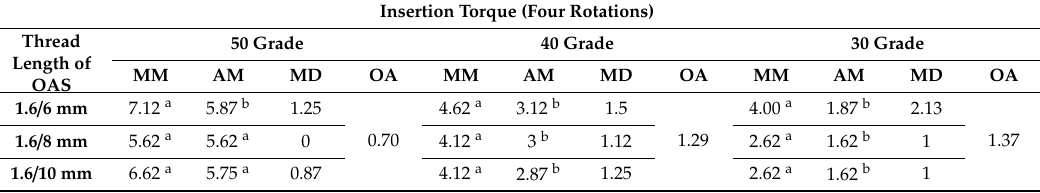
Table 5. Comparison of insertion torque values (four rotations) between the automatic device and manual anchorage methods.